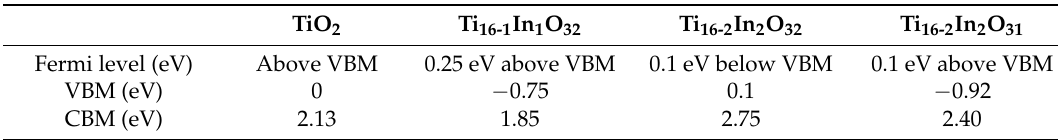
Table 2. Band edge and Fermi level positions in different systems. The valence band maximum and conduction band minimum are represented by VBM and CBM, respectively.